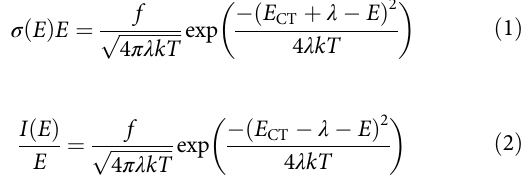
orientations of the donor layer. The V OC , on the other hand, is a substantial 150 mV larger when the donor molecules are face-on compared to edge-on. The solar cell characteristics here are averages of over 150 devices of each orientation; histograms for each parameter are available in Supplementary Fig. 5.